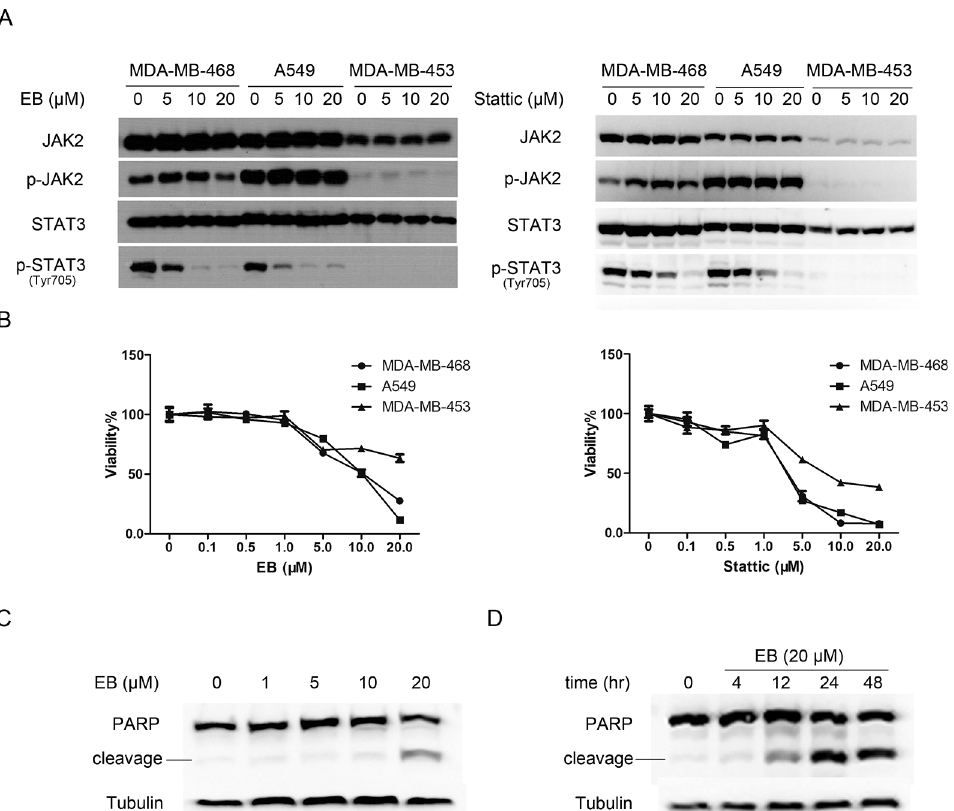
Fig 6. EB inhibited tumor cell growth by inducing apoptosis. (A) MDA-MB-468, A549, MDA-MB-453 cells (3.0 * 10 5 per well) were treated with EB or Stattic at indicated concentrations for 2 h. Whole cell lysates were processed for western blot analyses using antibodies as indicated. (B) MDA-MB-468, A549, MDA-MB-453 cells were treated with EB or Stattic at indicated concentrations for 48 h. The viability of the three cell lines was analyzed by MTT assay. (C) A549 cells were treated with EB at indicated concentrations for 12 h. The whole cell lysates were processed for western blot analysis using antibody as indicated. (D) A549 cells were treated with EB (20 μ M) for various time periods (0 – 48 h). Whole cell lysates were processed for western blot analysis using antibody as indicated.